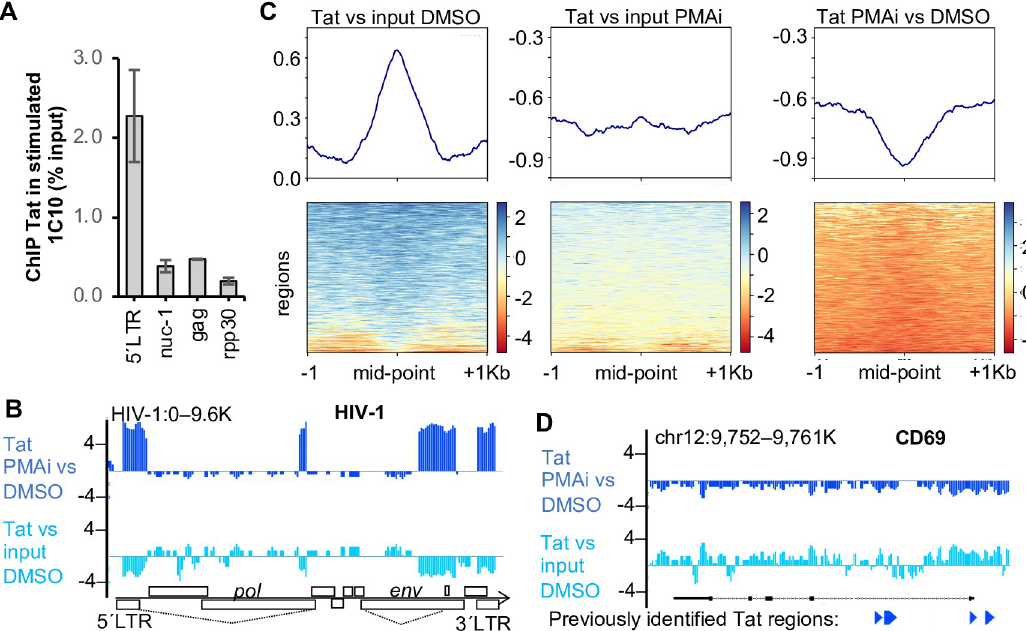
Fig 2. Tat is predominantly found at the HIV-1 promoter in PMA/i activated cells. (A) ChIP-qPCR of Tat at three positions of the HIV-1 provirus and control ( n = 3, s.e.m.). (B) Genome browser view of Tat ChIP-seq at the HIV-1 locus. (C) Heatmaps of ChIP-seq against Tat in cells unstimulated (DMSO) or stimulated (PMAi) relative to input or stimulated relative to unstimulated ( n = 2). (D) Genome browser view of Tat ChIP-seq, the CD69 locus with the exons in black and the Tat-ChIP peaks from Reeder et al (2015) [36] in blue at the